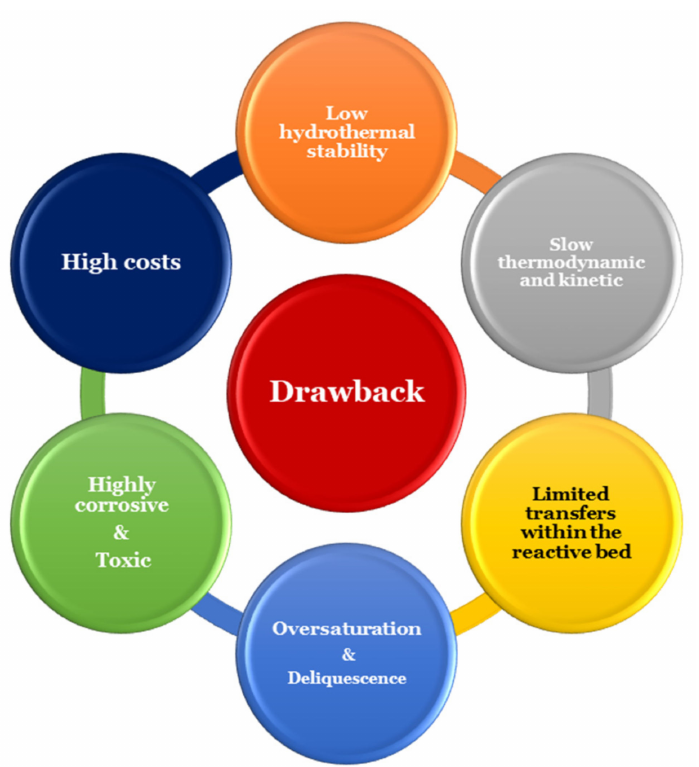
Figure 6. Drawback of using salts in TCES systems.